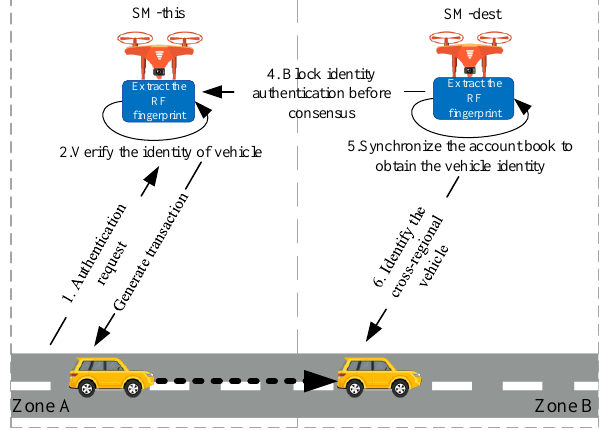
Figure 5. The process of cross-regional RF fingerprint identification of vehicles based on the hash